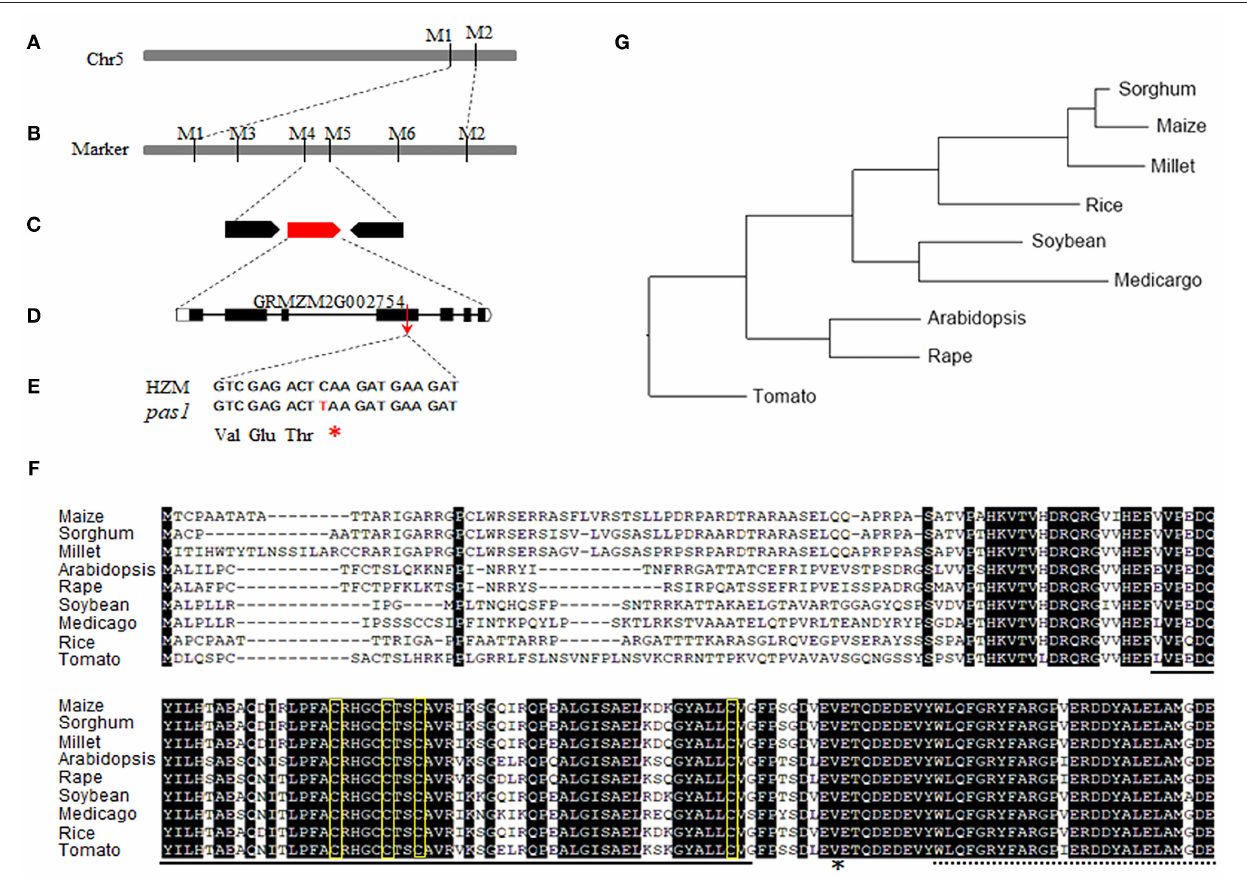
FIGURE 2 | Map based cloning of ZmFdC2 gene and the alignment of FdC2 proteins from various species. (A) , ZmFdC2 gene was roughly mapped between marker M1 and M2. (B) , The ZmFdC2 gene was further localized to a 104kb region between M4 and M5. (C) , Three candidate genes were annotated in the mapped region. (D) , The diagram representation of the ZmFdC2 gene structure. (E) , The C to T mutation in ZmFdC2 gene led to an extra stop codon. (F) , Sequence alignment of FdC2 proteins from various species. The solid and dashed lines under the letters indicate the 2Fer-2S cluster and the C-terminus extensions, respectively. The amino acids in yellow rectangles denote the conserved –CxxxxCxxCxn–C– motif, and the asterisk indicates the mutated position in ZmFdC2 . (G) , Phylogenetic tree of all FdC2 homologs from selected